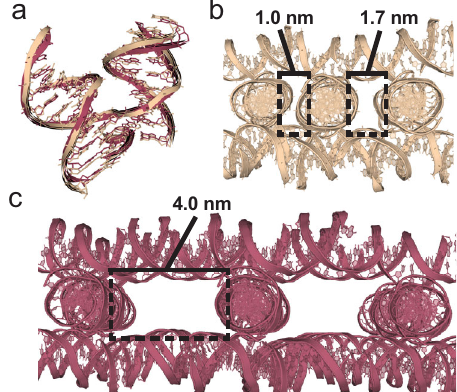
Fig. 2 Discrete differences in junction angles determine global lattice symmetry. a Superimposed structures of the J5 (tan) and J3 (red) 4 × 5 junctions containing P 3 2 21 and P 3 2 symmetries, respectively. The junction alignment had a global RMSD value of 1.34, with calculated interduplex angles of 58.18° and 55.20°, respectively. No signi fi cantly obvious visual differences are apparent; however, the resulting global in fl uence that an even modest difference in angle can have on overall packing is evident in ( b , c ). b Snapshot of the full J5 P 3 2 21 (4 × 5) lattice containing an aperiodic array of cavities which would not be amenable for scaffolding of guest molecules of any appreciable size. The two uniquely sized cavities are shown with black boxes. The widths for each respective cavity are indicated. Each cavity spans the length of a cross-section of a duplex (~2.0 nm). Alternative views of the lattice including measurements in each orientation are included in Supplementary Fig. 8. c Snapshot of the full J3 P 3 2 (4 × 5) lattice which reveals dramatically different arrays of large periodic cavities compared to its J5 counterpart in ( b ). A single cavity is highlighted with a black box with a width of 4.0 nm and also spanning the length of a cross-section of a duplex (~2.0 nm). Alternative views of the lattice including measurements in each orientation are included in Supplementary Fig.